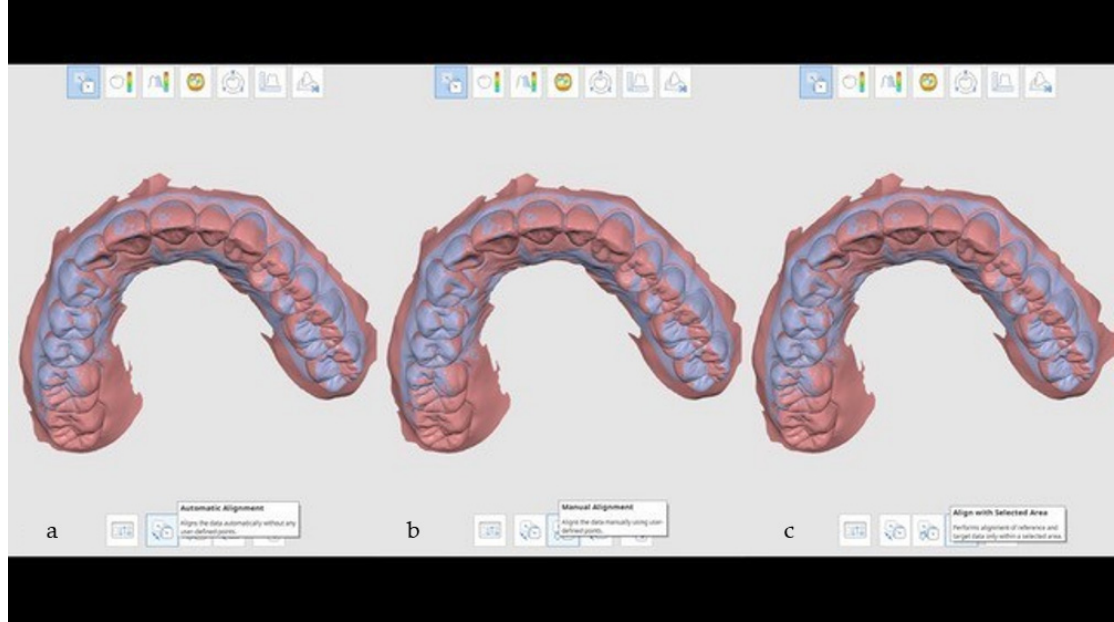
Figure 5. Three different methods can be used to align STL files: ( a ) automatic, ( b ) manually by clicking similar points on the two STL files, and ( c ) alignment with selected areas, in which only the selected areas were aligned.